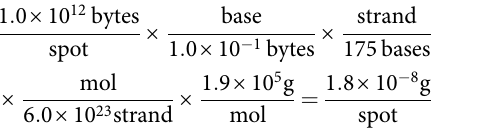
Fig. 3 DMF setup to test for contamination through the oil. Black ink is used to visually mark DNA spot locations, and light circular blobs are water droplets. Droplets moved in tandem up to the spot, stayed for 60 s, and returned to their original